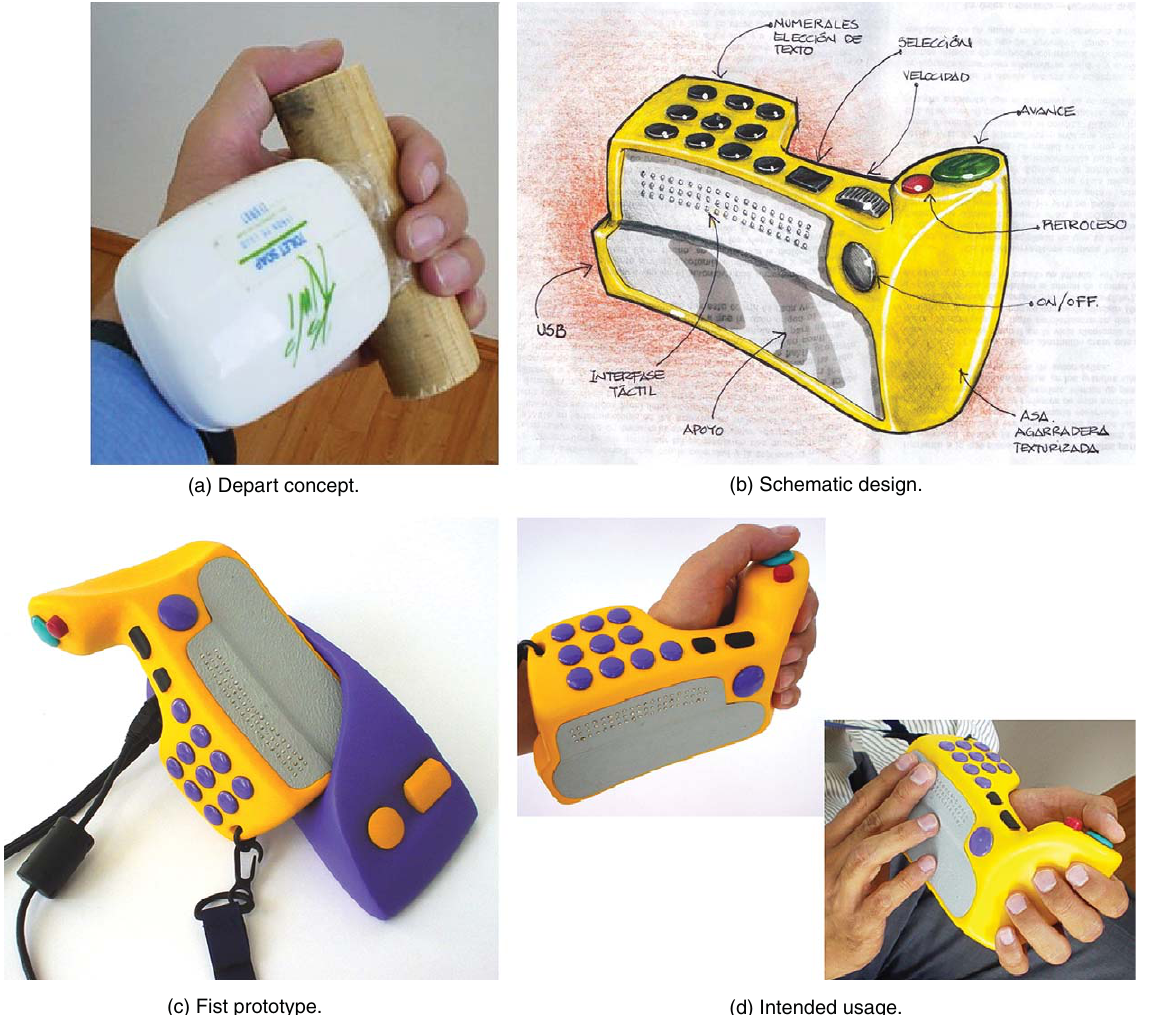
Fig. 17. Concept and implementation of an ergonomic enclosure for the TactoBook Braille